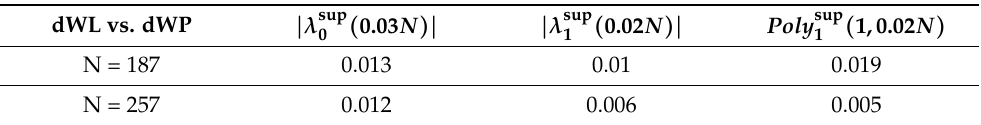
Table 3. The p -values of some variables for the Mann–Whitney U test between dWL and dWP. The number of cells is set at 187 and